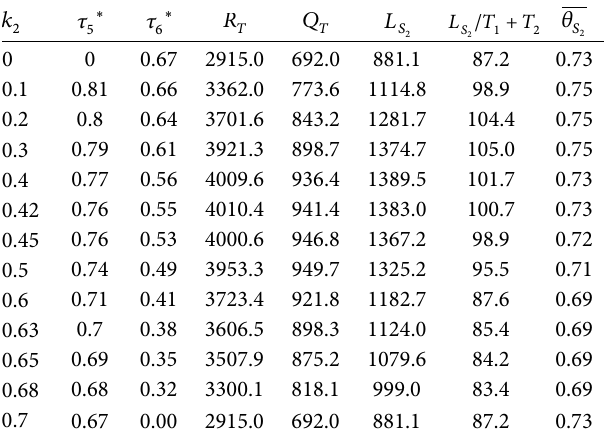
Table 7: Product sales and average freshness under optimized variable